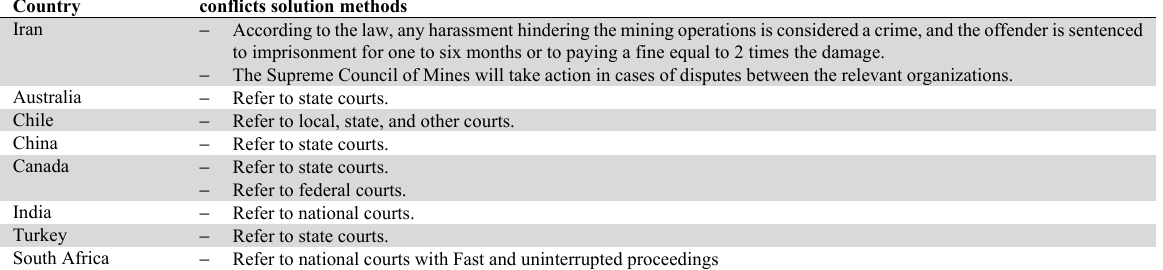
Conflicts solution methods